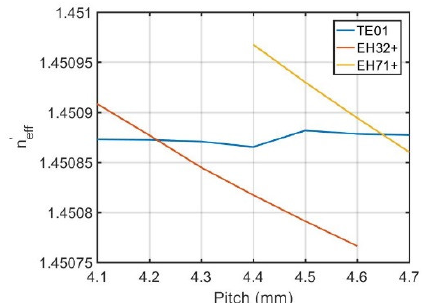
Figure 5. Modal coupling between a guided mode TE 01 and leaky modes EH 32+ and EH 71+ in a twisted octagon-shaped core fiber with R = 25 μm, NA = 0.065, λ = 1064 nm, and Λ in the range of 4.1–4.7 mm.